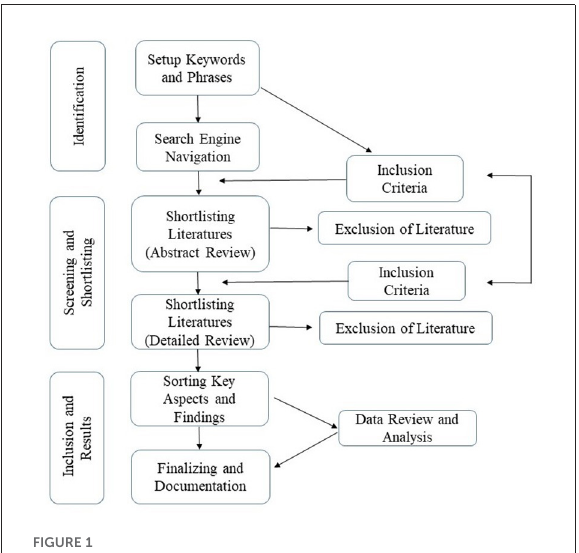
FIGURE1 A systematic flow chart of the methodology.